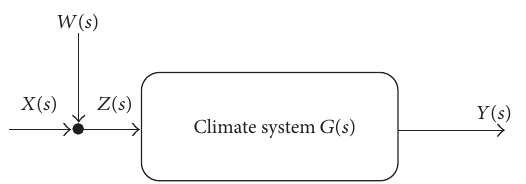
Figure 5: Two largest Lyapunov exponents.